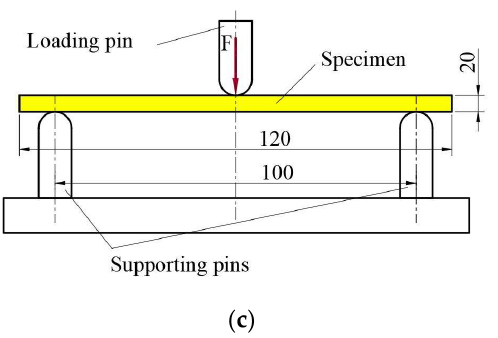
Figure 8. The 3-point bending setup for the hexagonal cells specimen: ( a ) force along the Y-axis of the specimen, ( b ) force along the Z-axis of the specimen, ( c ) device layout.